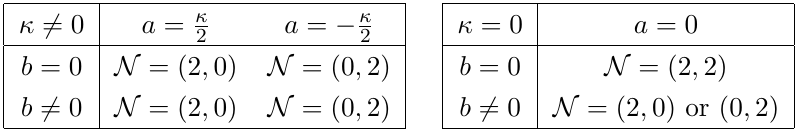
Table 3 . Classi(cid:12)cation of topologically twisted 4d N = 1 SCFTs on Riemann surfaces of constant curvature (cid:20) = (cid:6) 1 ; 0 in terms of the surviving amount of supersymmetry in 2d. We include the possibility of a twist along the (cid:13)avor symmetries, with (cid:13)ux b . to be of de(cid:12)nite chirality and reduces supersymmetry to N = (2 ; 0) for Y N = (0 ; 2) for Y = (cid:0) b j e j (cid:10) i i 23